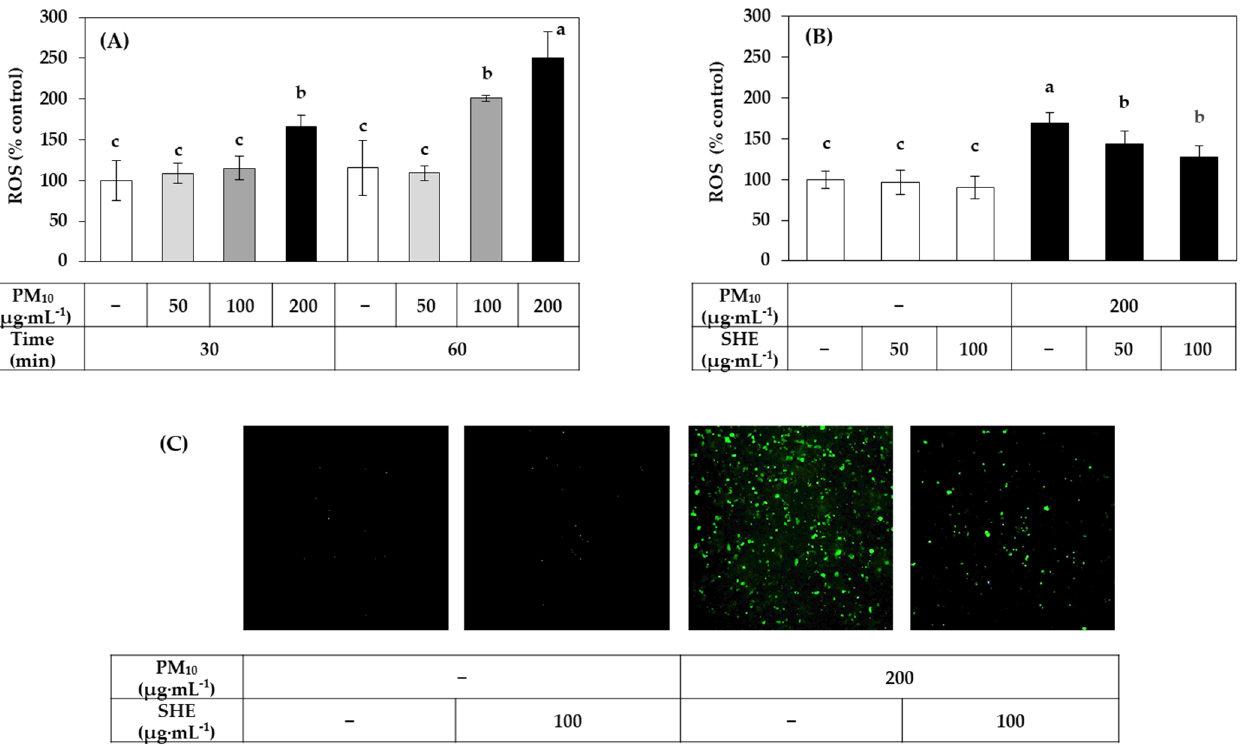
Figure 4. Effects of SHE on the reactive oxygen species (ROS) production in HaCaT keratinocytes exposed to PM 10 . In ( A) , cells were labeled with 2 ′ ,7 ′ -dichlorofluorescin diacetate (DCFH-DA) and exposed to PM 10 at the indicated concentrations for 30 min or 60 min. In ( B , C ), cells were labeled with DCFH-DA, treated with SHE at the indicated concentrations, and exposed to PM 10 (200 μ g mL − 1 ) for 60 min or not. Typical images of cells fluorescing due to the oxidation of DCFH-DA by ROS are shown in ( C ). The fluorescence of the cell extracts was measured to determine ROS levels ( A , B ). Data are presented as mean ± SD ( n = 5 for ( A ) and n = 6 for ( B )). Duncan’s multiple range test was performed to compare all group means to each other. Groups that share the same letters (a–c) do not have significantly different means at the p < 0.05 level.